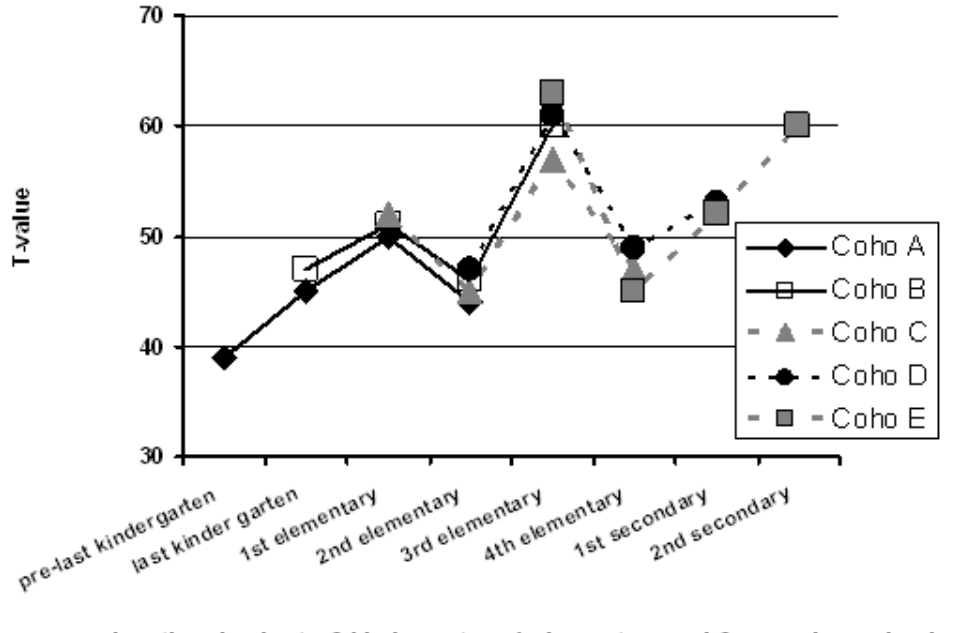
Figure 5. Cross-sequential results on ideational fluency in the German sample.